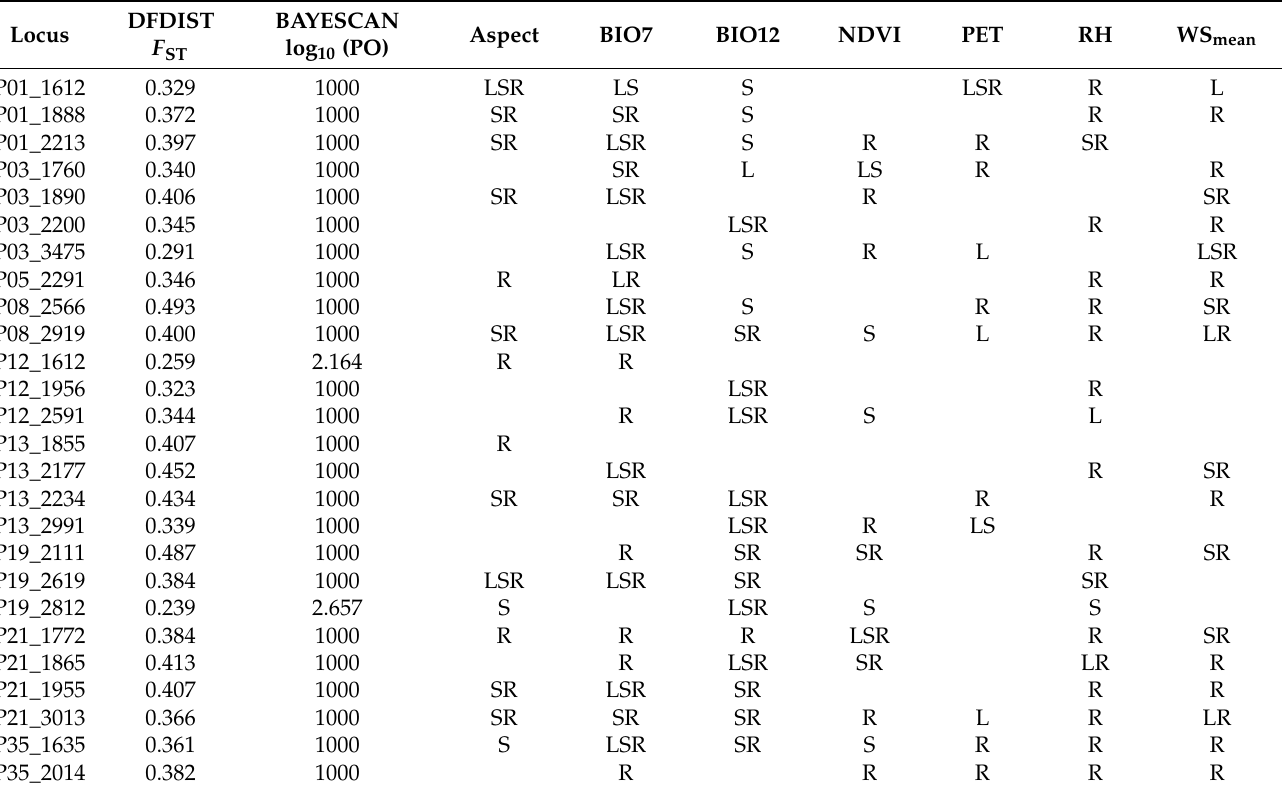
Table 3. F ST outliers identified via BAYESCAN and DFDIST and strongly associated with environ- mental variables. Codes below the environmental columns (aspect, BIO7, BIO12, NDVI, PET, RH, and WS mean ) represent strong correlations between F ST outliers and environmental variables identified using LFMM (L), Sam β ada (S), and rstanarm (R).